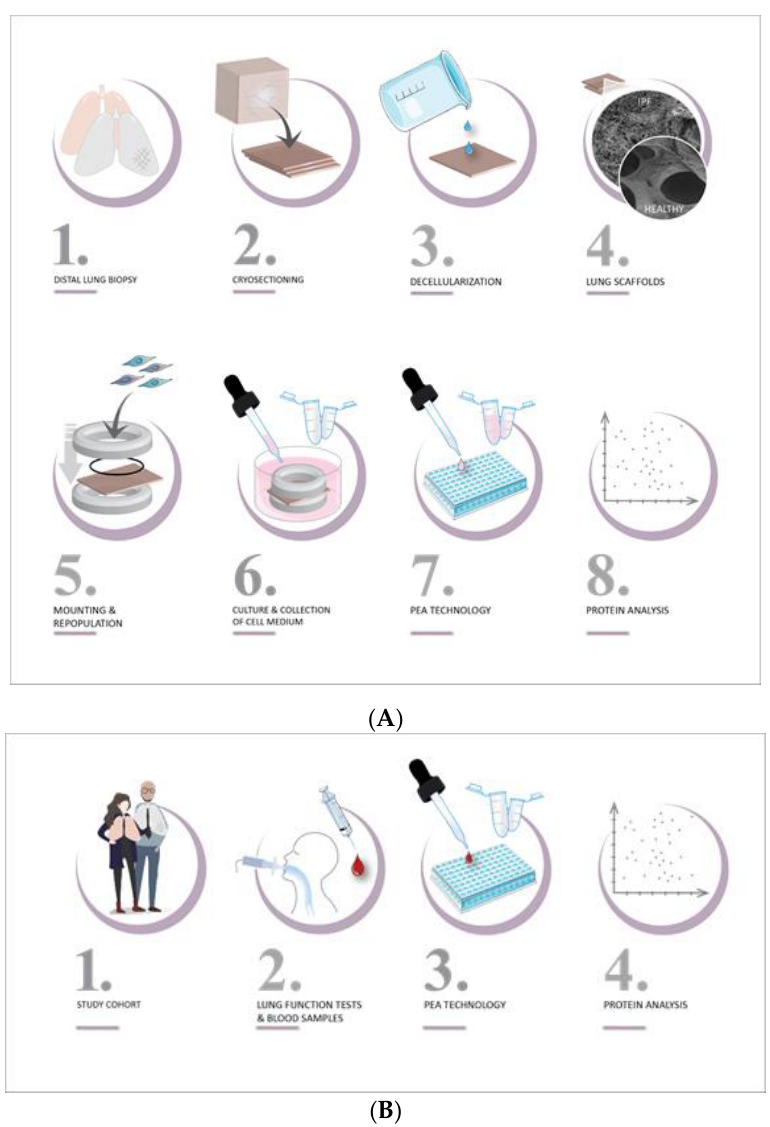
Figure 6. Translational study design of protein profiling of IPF. ( A ) top image, ( B ) bottom image. ( A ) Ex vivo model. (1) Cubes of 1 cm 3 of distal lung tissue were dissected from lungs of healthy donors and IPF patients, and directly frozen. (2) Tissue was cryosectioned into 350 µ m thin slices. (3) Cells were removed with detergent solution containing CHAPS. (4) The decellularized lung tissue (scaffolds) presented maintained tissue morphology with disease features. (5) Scaffolds were repopulated with healthy lung fibroblasts and mounted in custom-made holders, keeping scaffolds in a stretch formation. (6) Repopulated scaffolds were cultured up to 9 days, where cell medium was collected at day 1 and day 9. (7) 92 proteins (immuno-oncology panel) were analyzed in collected cell medium using proximity extension assay technology. (8) The proteomic profile of each sample was reported as relative protein amount (NPX value). ( B ) IPF patients. (1) A cohort of 77 healthy donors (smokers and non-smokers) and 38 IPF patients (from the IPF-registry) were included. (2) Blood samples from IPF patients were collected at baseline and at follow up with associated lung function parameters and clinical data. (3) Serum samples were analyzed for 92 proteins (immuno-oncology panel) using PEA technology. (4) The proteomic profile of each sample was detected reported as NPX value and correlated to lung function parameters.